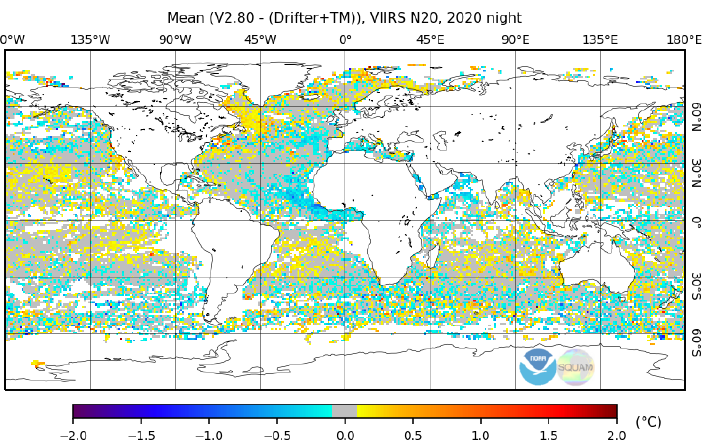
Figure 5. Aggregated for year 2020 maps of nighttime N20 VIIRS ‘subskin’-(D+TM) SST. The figure is from the NOAA SST Quality Monitor (SQUAM) online system [18].